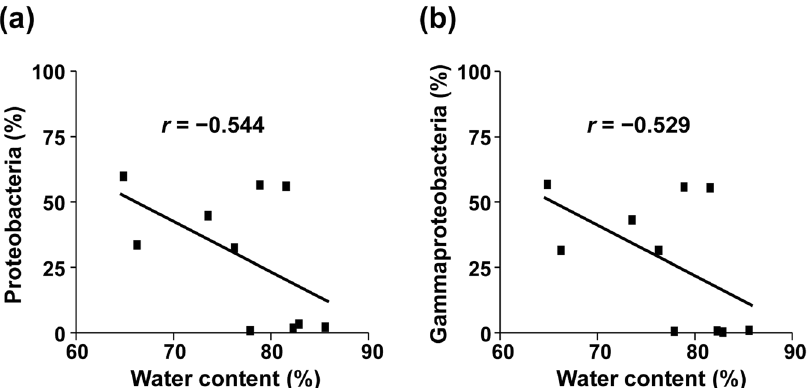
Figure 4. Relationship between water content in feces and the proportion of Proteobacteria and Gammaproteobacteria. The proportion of Proteobacteria ( a ) and Gammaproteobacteria ( b ) is shown for highly concentrated fecal samples (0.3 g/ml) in GuSCN solution after storage for one month at room temperature. r , Pearson correlation